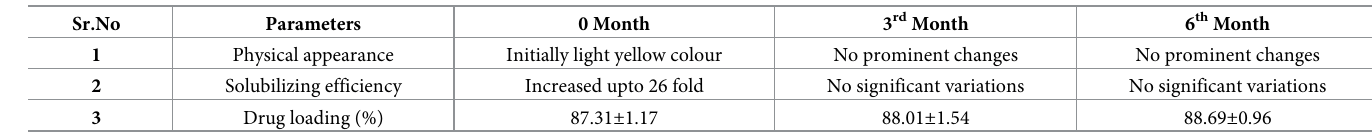
Table 9. Stability studies of rosuvastatin-loaded nanogels.